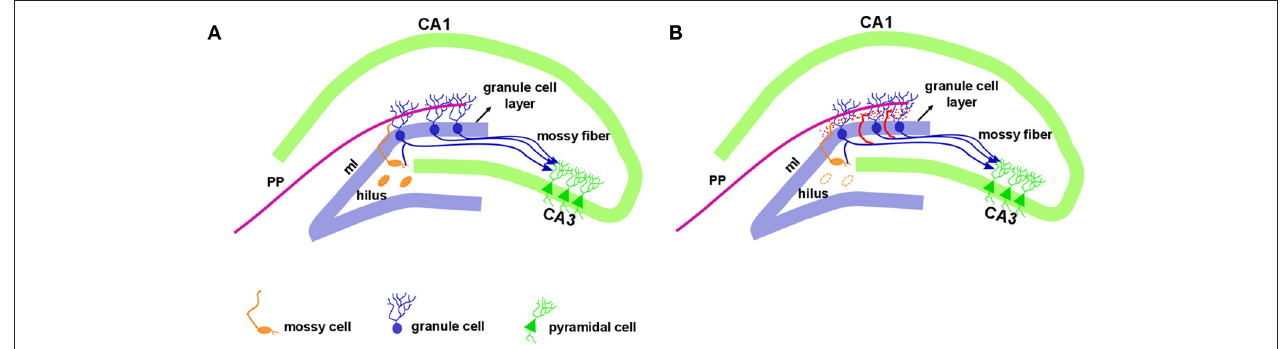
FIGURE 1 | Hippocampal formation in the normal and epileptic brain. The dentate gyrus granule cell layer is densely packed with small diameter cell bodies named granule cells. Just above the granule cell layer is the molecular layer (ml) that is considered cell-free, as it contains the apical dendrites of granule cells. The outer molecular layer receives entorhinal cortex information via a performant pathway (PP). Granule cell axons, named mossy fibers, extend to the hilus with projection to the mossy cells and CA3 pyramidal neurons. The mossy cell axons project to contralateral granule cell dendrites in the inner molecular layer (A) . In the epileptic hippocampus, with the loss of mossy fibers target in the hilus, the granule cell axons sprout and extensively innervate the dentate inner molecular layer of the hippocampus, a phenomenon called mossy fiber sprouting, illustrated in red (B) .